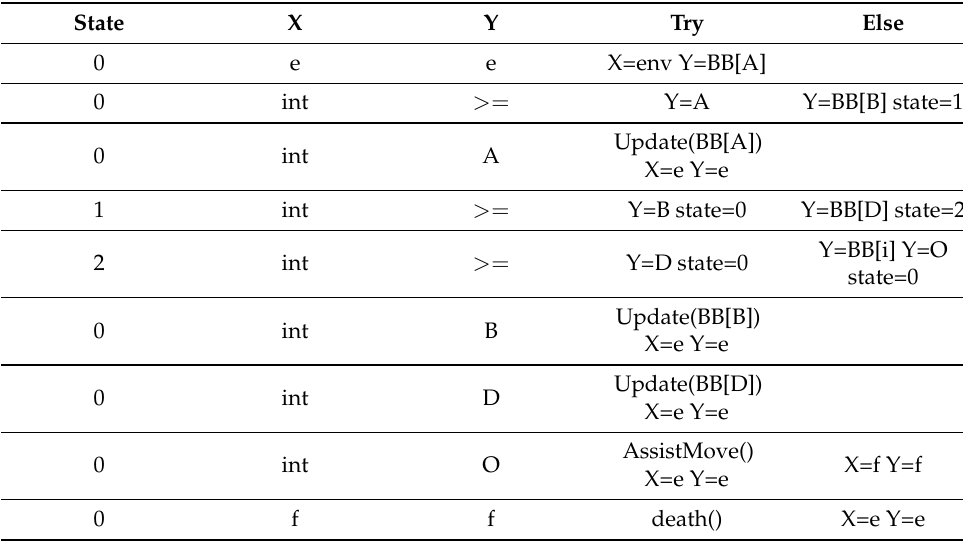
Table 2. GWO-2D P colony model, the definition of the rules.